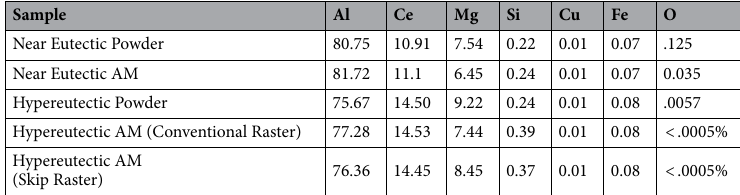
Table 1. Measured Chemical Composition of Atomized Powder and As-Fabricated Parts. All values are in wt%.